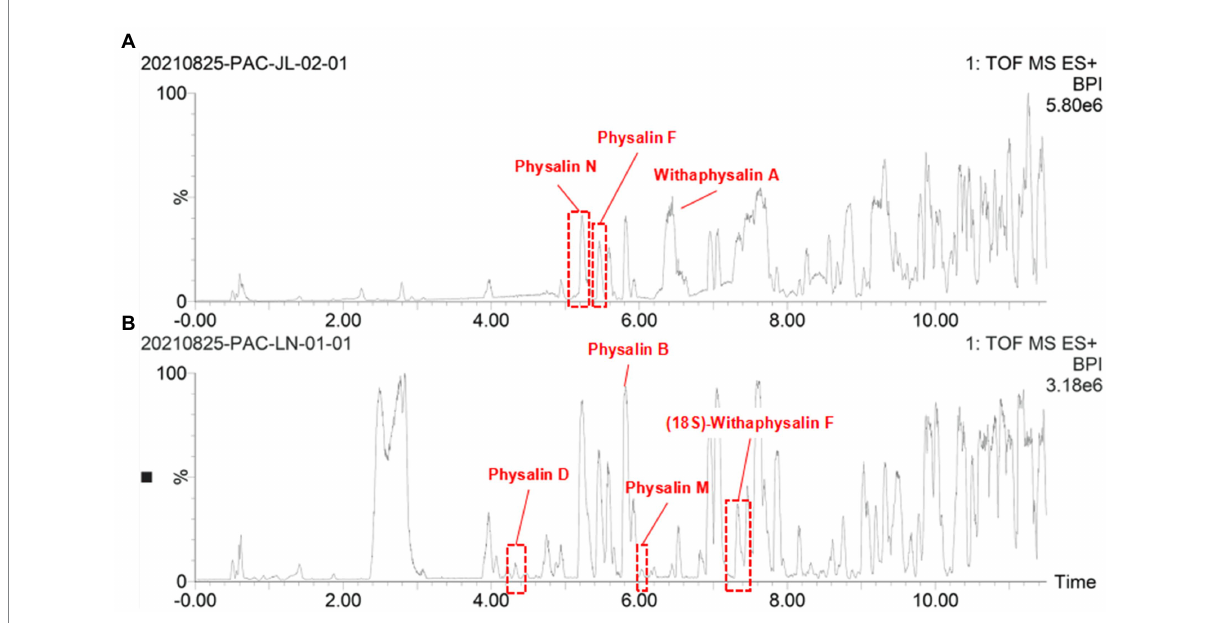
FIGURE 7 The BPI chromatograms of calyx form Jilin and Liaoning provience. (A) The BPI chromatograms of calyx of P. alkekengi. Form Jilin. (B) The BPI chromatograms of calyx of P. alkekengi. Form Liaoning.